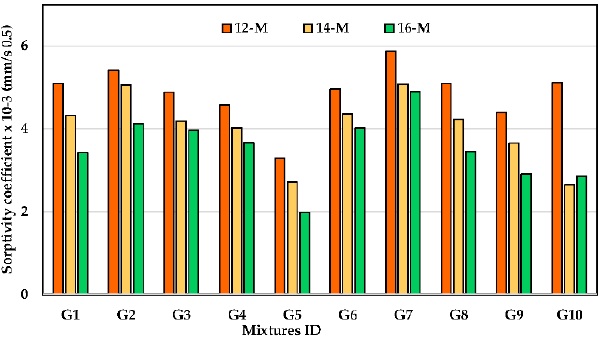
Figure 11. Effect of KOH molarity and binder type on sorptivity coefficient of the UHPGC at curing heat 60 °C.